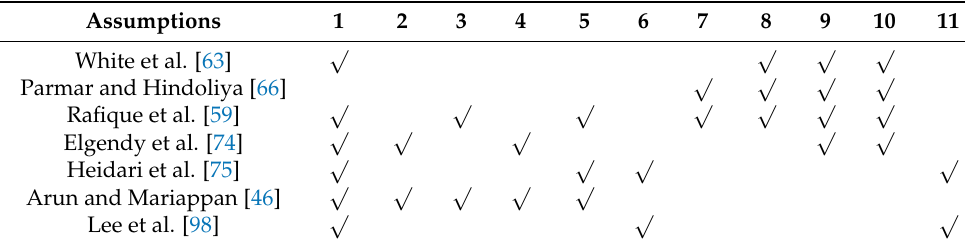
Table 4. Main assumptions used in numerical